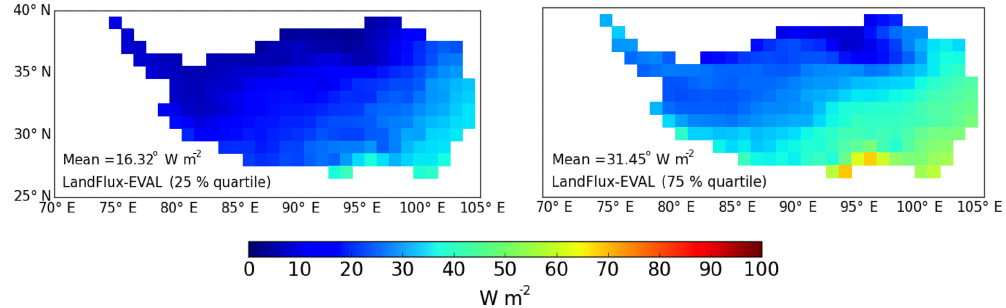
Figure 4. The annual mean spatial patterns of 25th percentile and 75th percentile of the LandFlux-EVAL multi-datasets ensemble.